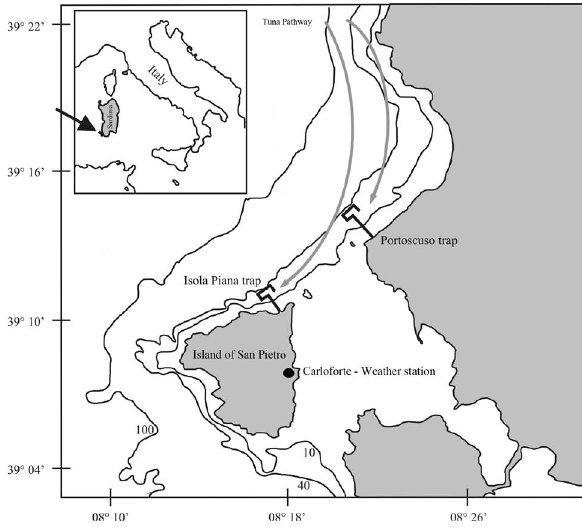
Fig. 1. – Location of the study area and pathways where bluefin tuna are intercepted by the trap fishery in southwestern Sardinia (W Mediterranean). The present investigation was conducted at the Isola Piana trap. The village of Carloforte hosts the weather station of the Italian Air Force’s Meteorological Service, where meteoro- logical data were